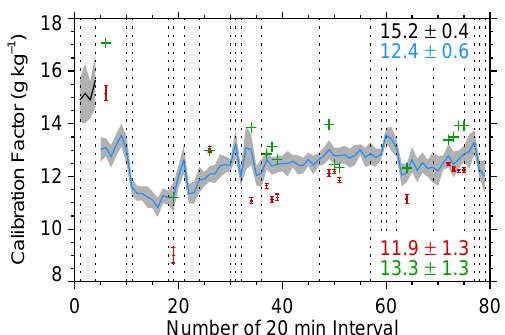
Figure 5. Calibration factor of Polly XT using the IWV method as function of time given in number of 20min interval. The black and the blue solid lines indicate the calibration factor before and af- ter the major rearrangement of the optical setup on 15 April 2013, 10:06UTC, respectively. The grey areas denote the standard devi- ation during each 20min interval. The numbers represent the ac- cording means and standard deviations over the time. The grey dot- ted lines demonstrate rearrangements on Polly XT especially adjust- ments of the overlap or cleanups of the quartz plate in the roof of the Polly XT cabinet or they indicate leaps in the time of more than 4h. The calibration factors of the regression and the profile method are indicated by red points with error bars and green plus signs,